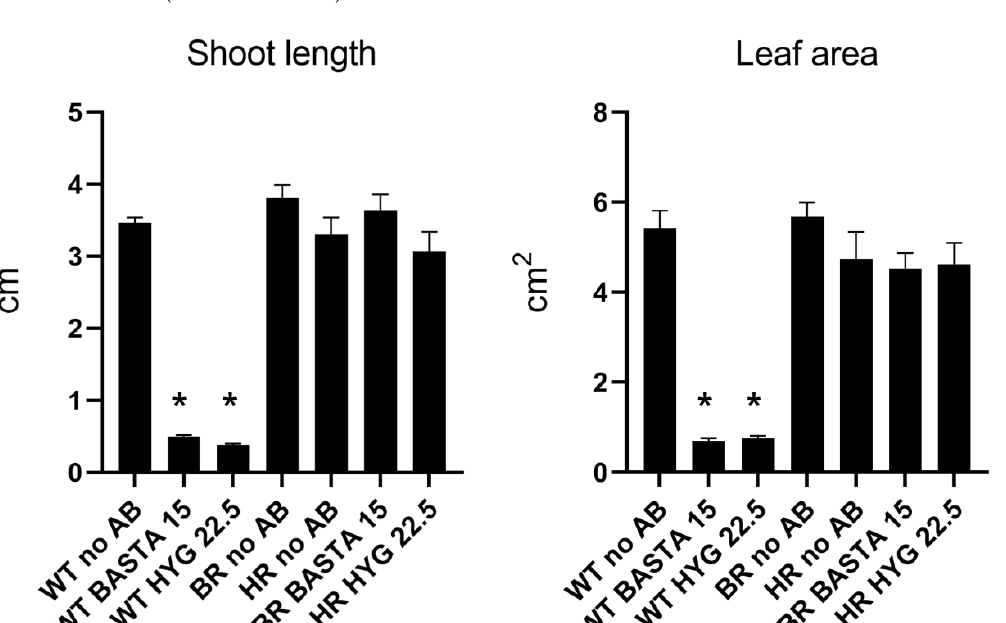
Figure 5. Selection of transgenic Camelina on MS media containing 15 mg/L of BASTA. Pictures taken after 14 days. ( A ) WT Camelina sativa ( B ) Segregating T2 generation of pB2GW7 transformants (BASTA-resistant).